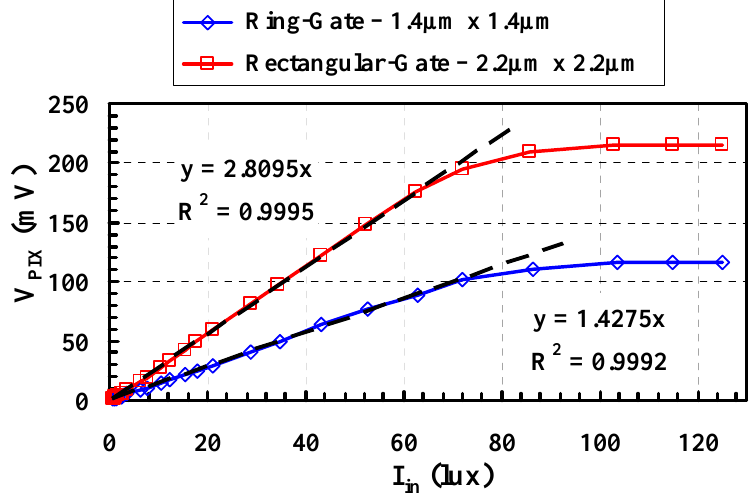
Figure 9. Photo-conversion transfer characteristic curves of two design configurations: 2.2 µm-pitch rectangular-gate pixel and 1.4 µm-pitch ring-gate pixel respectively.